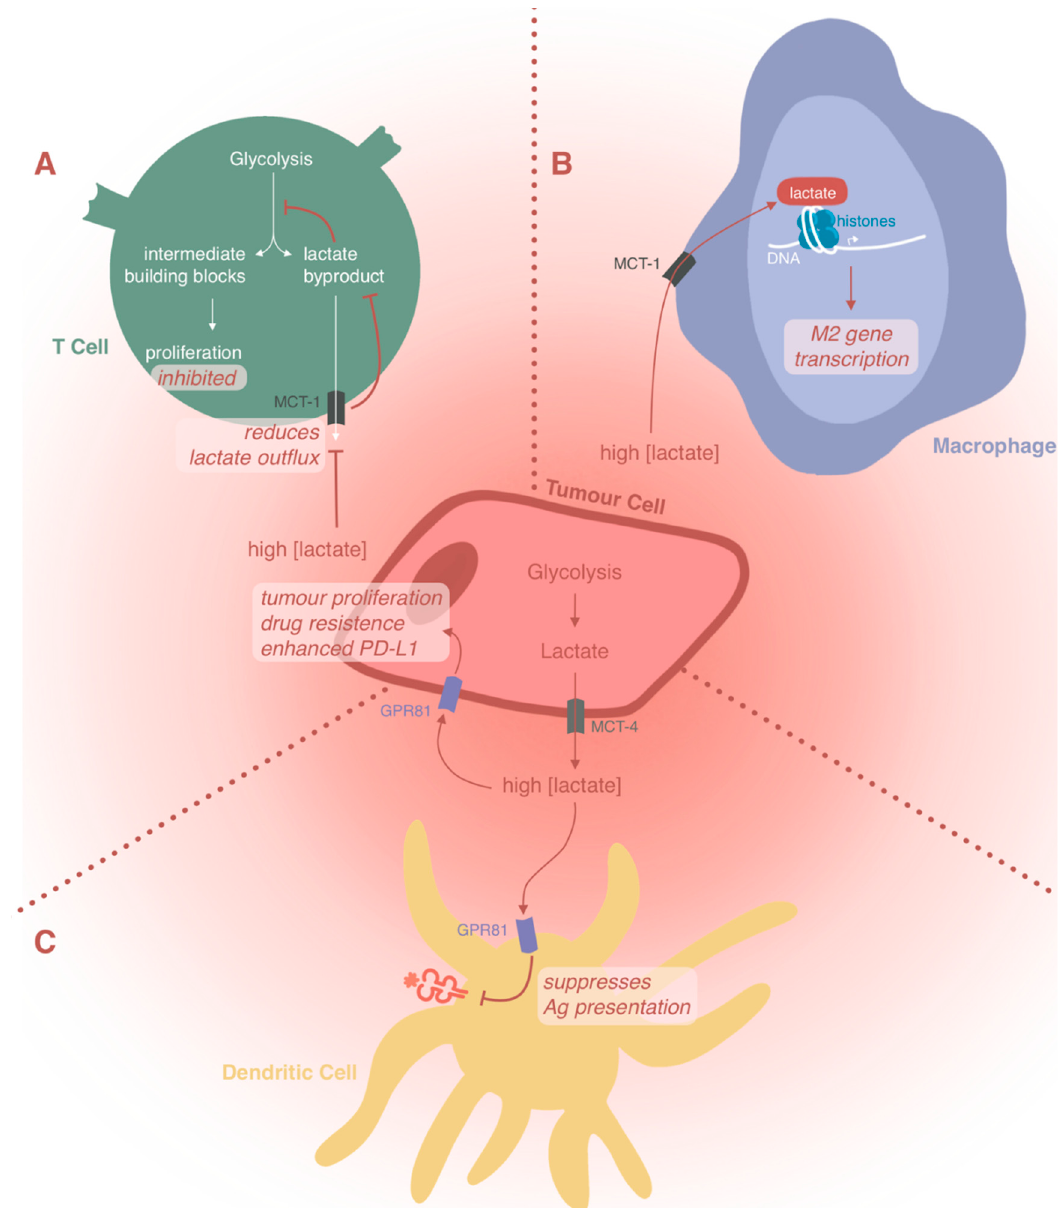
Figure 2. The molecular mechanisms by which lactic acid modulates immune cell responses. Lactic acid promotes cancer cell proliferation, drug resistance, and enhanced expression of programmed death-ligand 1 (PD-L1). In addition, lactic acid is responsible for suppressing antitumor immunity. ( A ) High lactic acid concentrations in the tumor microenvironment disrupts the [H+] gradient between T cells and their environment, reducing monocarboxylate transporter 1 (MCT1)-mediated lactic acid export from T cells. This inhibits effector T cell proliferation. ( B ) Lactic acid acts as an epigenetic regulator and induces M2 macrophage polarization through epigenetic reprogramming. It directly binds to histone lysine lactylation (Kla) sites (28 of these have been experimentally identified) to direct downstream gene transcription, thereby inducing M2 polarization and enhancing inflammation-independent biological pathways. ( C ) Lactic acid acts as a signaling molecule. G protein-coupled receptor GPR81 is a lactic acid receptor found on both immune cells and cancer cells. Its activation in cancer cells promotes proliferation, drug resistance, and enhanced expression of PD-L1. Its activation on DCs is associated with decreased levels of cAMP, IL-6, IL-12, and suppressed antigen (Ag) presentation.